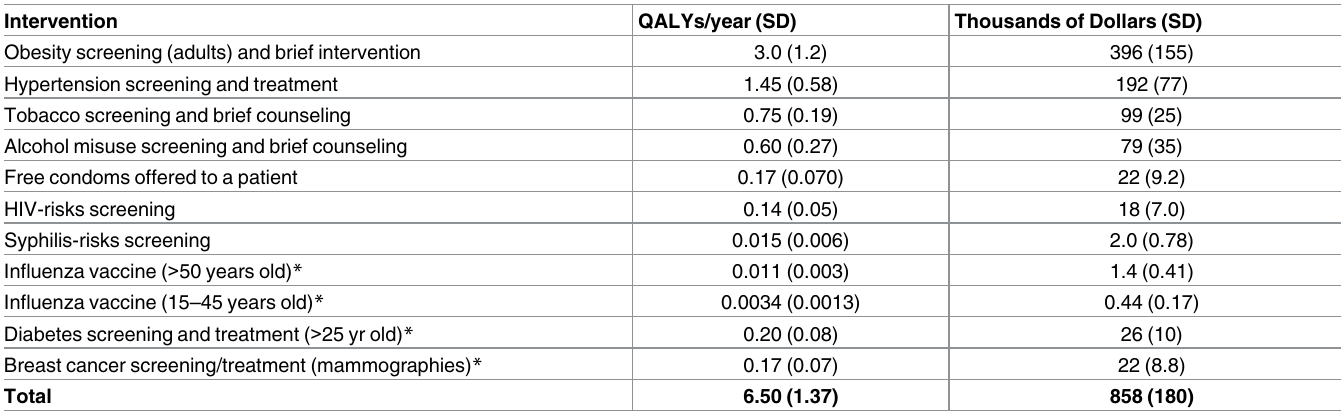
Table 3. Annual health and economic impact of the preventive health interventions at